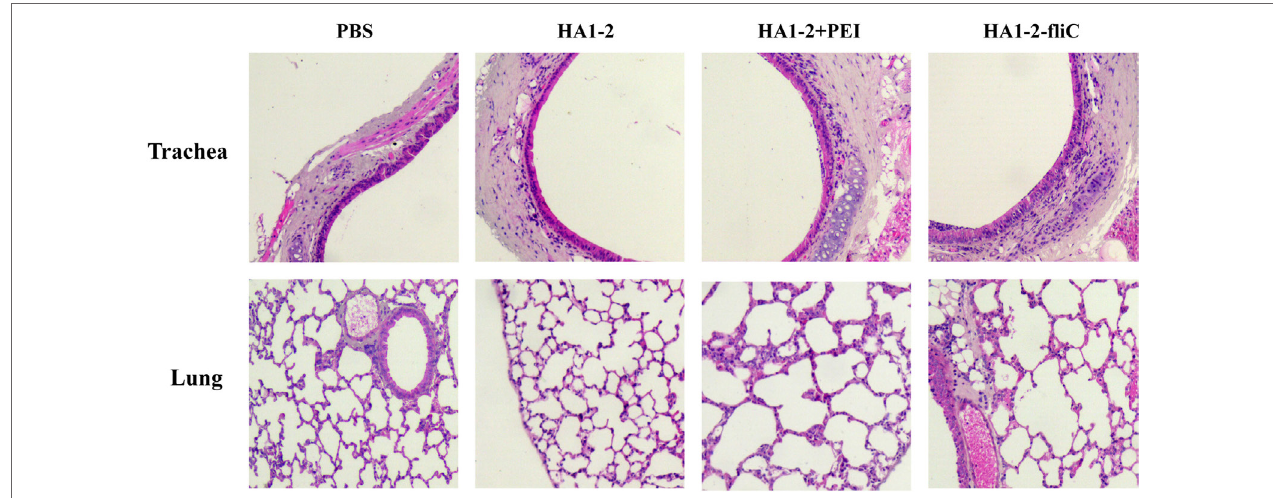
FigUre 7 | histological analysis . C3H/HeJ mice ( n = 3) were vaccinated intranasally with one dose of PBS, HA1–2, HA1–2-fliC, or HA1–2 combined with PEI. The lungs and trachea were removed from mice at 12-h postvaccination, and tissue sections were prepared and stained with H&E for histological analysis (100 ×